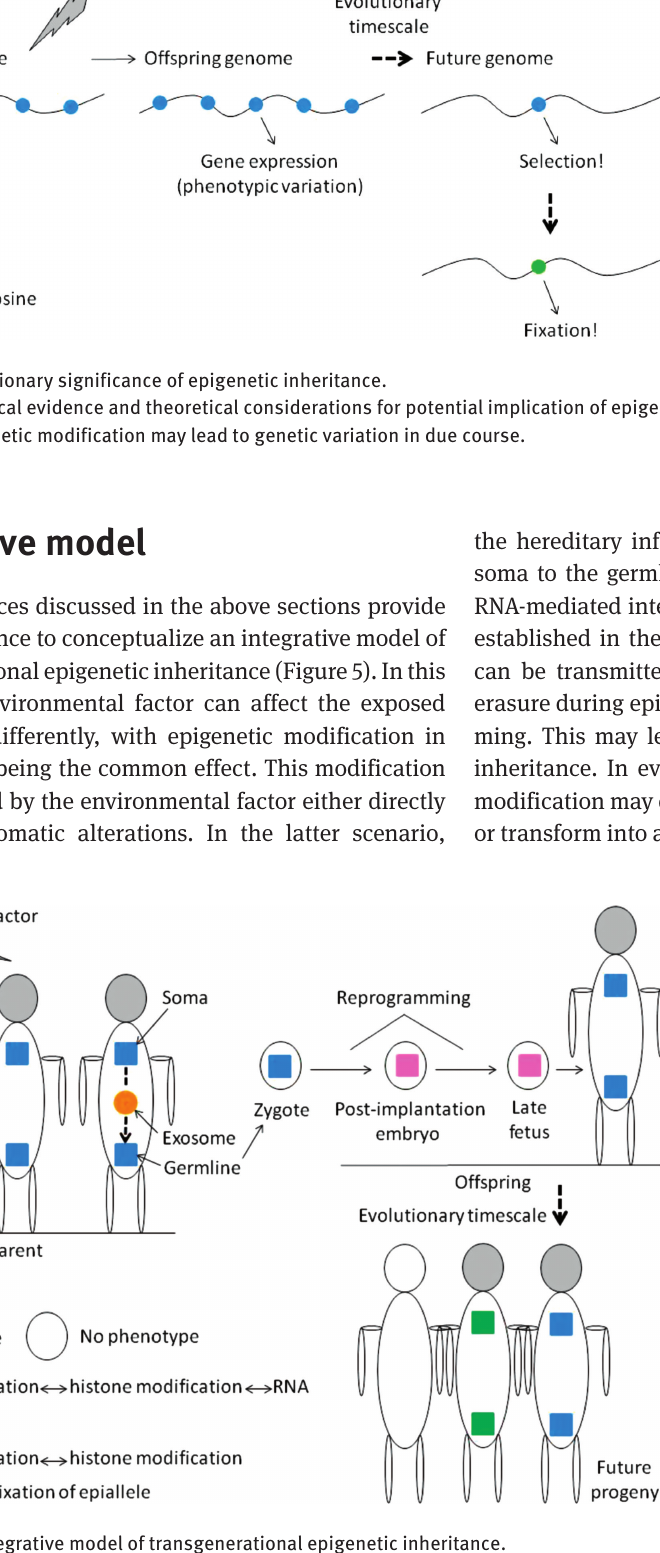
Figure 5: An integrative model of transgenerational epigenetic inheritance. The model is based on available and suggestive evidence presented in Figures 1–4. Note integration of gene-environment interaction, systems biology and